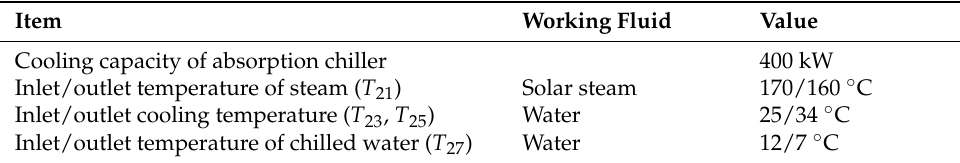
Table 4. Initial conditions of simulation for absorption chiller [37].